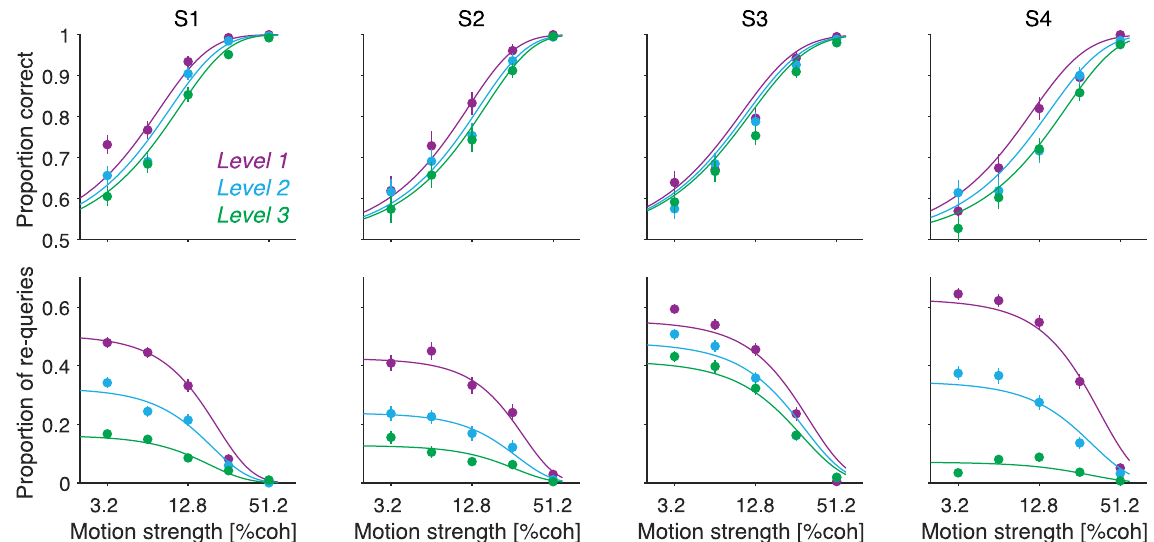
Fig 3. Motion choices depend on motion strength and tree level. The top row shows the proportion of correct motion choices as a function of motion strength. The bottom row shows the proportion of queries that were followed by another query at the same node. Solid curves are fits of a detection model. Decisions made at different levels of the decision tree are displayed in different colors. Each column shows data from one participant (S1 to S4). Error bars indicate s.e.m.